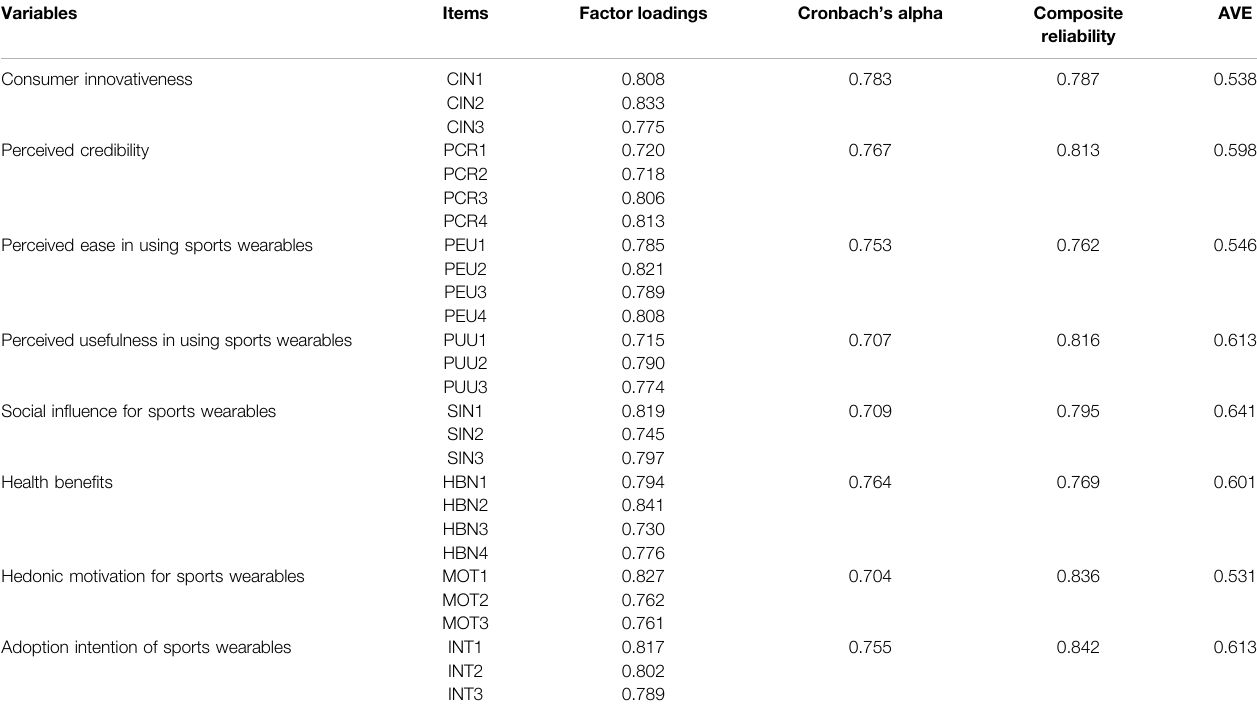
TABLE 3 | Measurement model results.